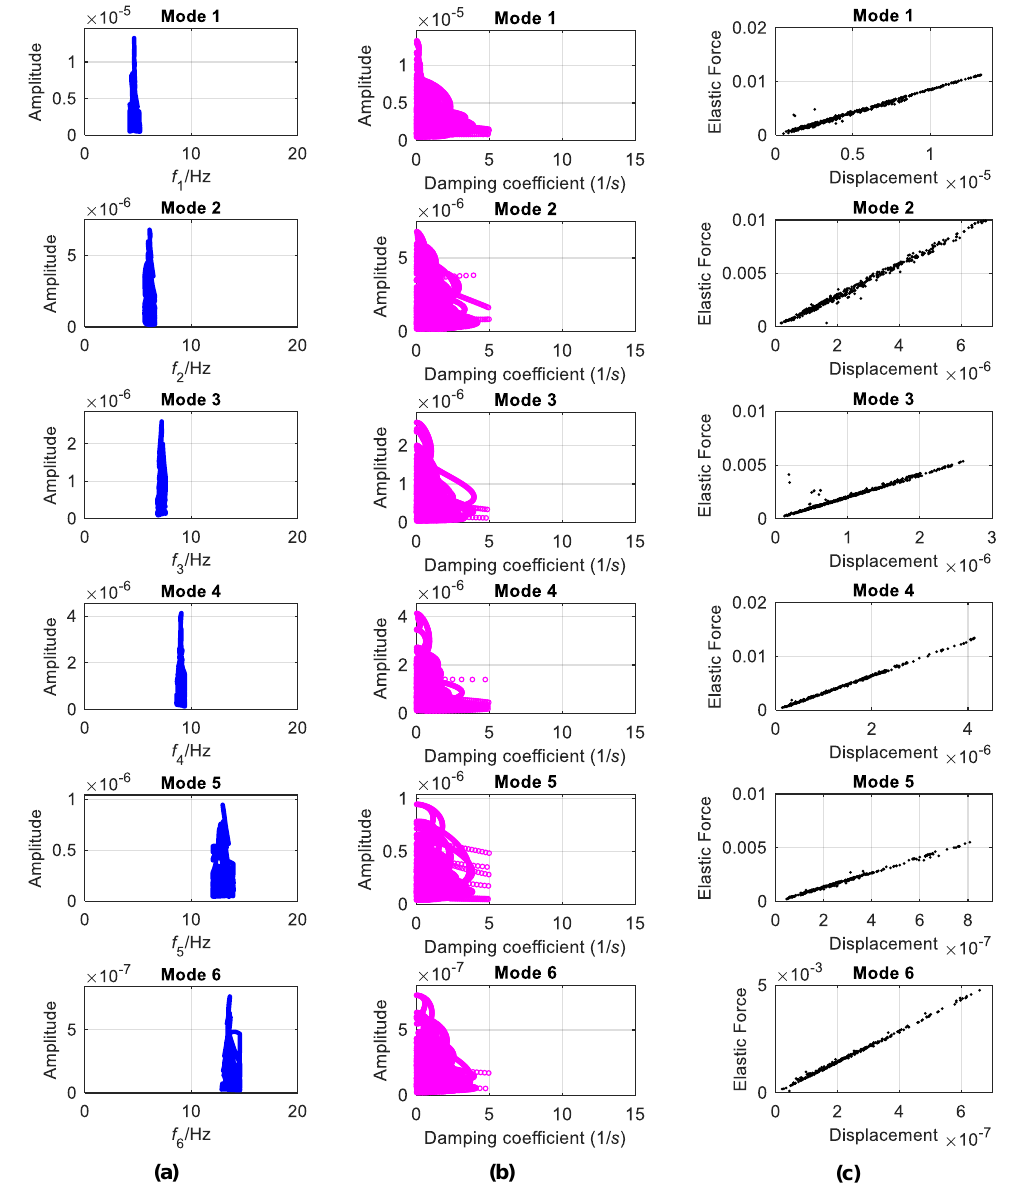
Figure 20. Linear characteristics identified from mono-components of DHF signal: ( a ) Backbones; ( b ) damping coefficients; ( c ) elastic forces.